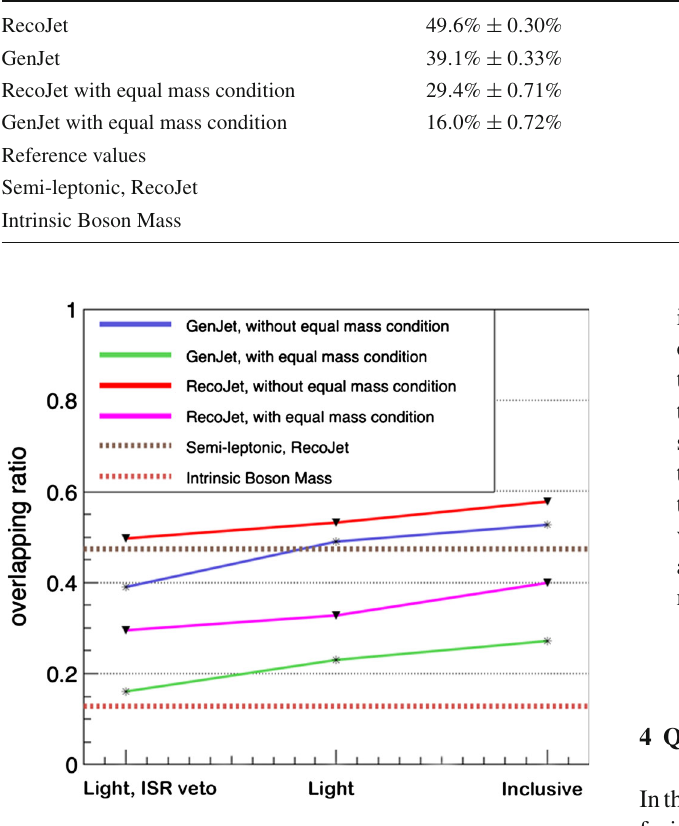
Fig. 14 The overlapping fractions for different cases. The X-axis indi- cates the different sample restrictive conditions: the light flavor samples